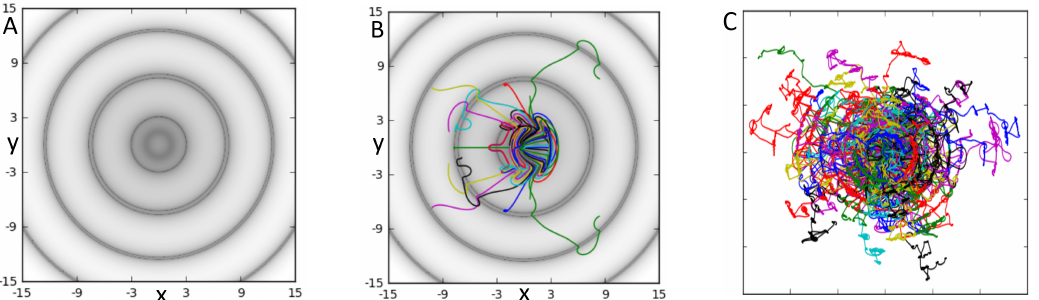
Figure 3: Example depicting metastable null geodesic bound states along ne- matic